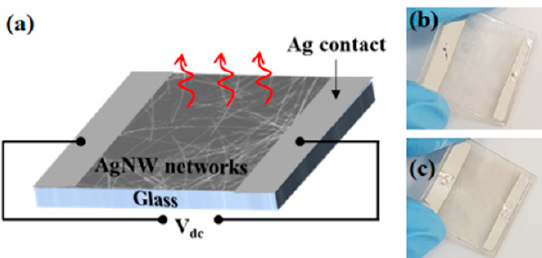
Figure 4. ( a ) Schematic illustration of layouts for a film heater with Ag NWs networks. ( b,c ) A photograph of Ag NWs of the thick and thin diameter-based film heaters (size = 20 × 20 mm 2 ).